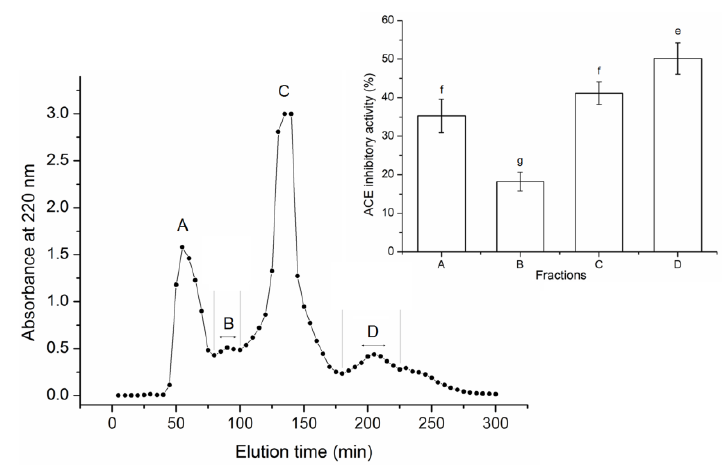
Figure 1. Purification profiles of sargassum maclurei protein hydrolysates (SMPHs) on Sephadex G-15 gel chromatography and the angiotensin I-converting enzyme (ACE) inhibition capacity of the subfractions. Uppercase letters (A–D) above the line represent the subfractions. Different lowercase letters (e–g) on the bars indicate a significant difference ( p < 0.05).